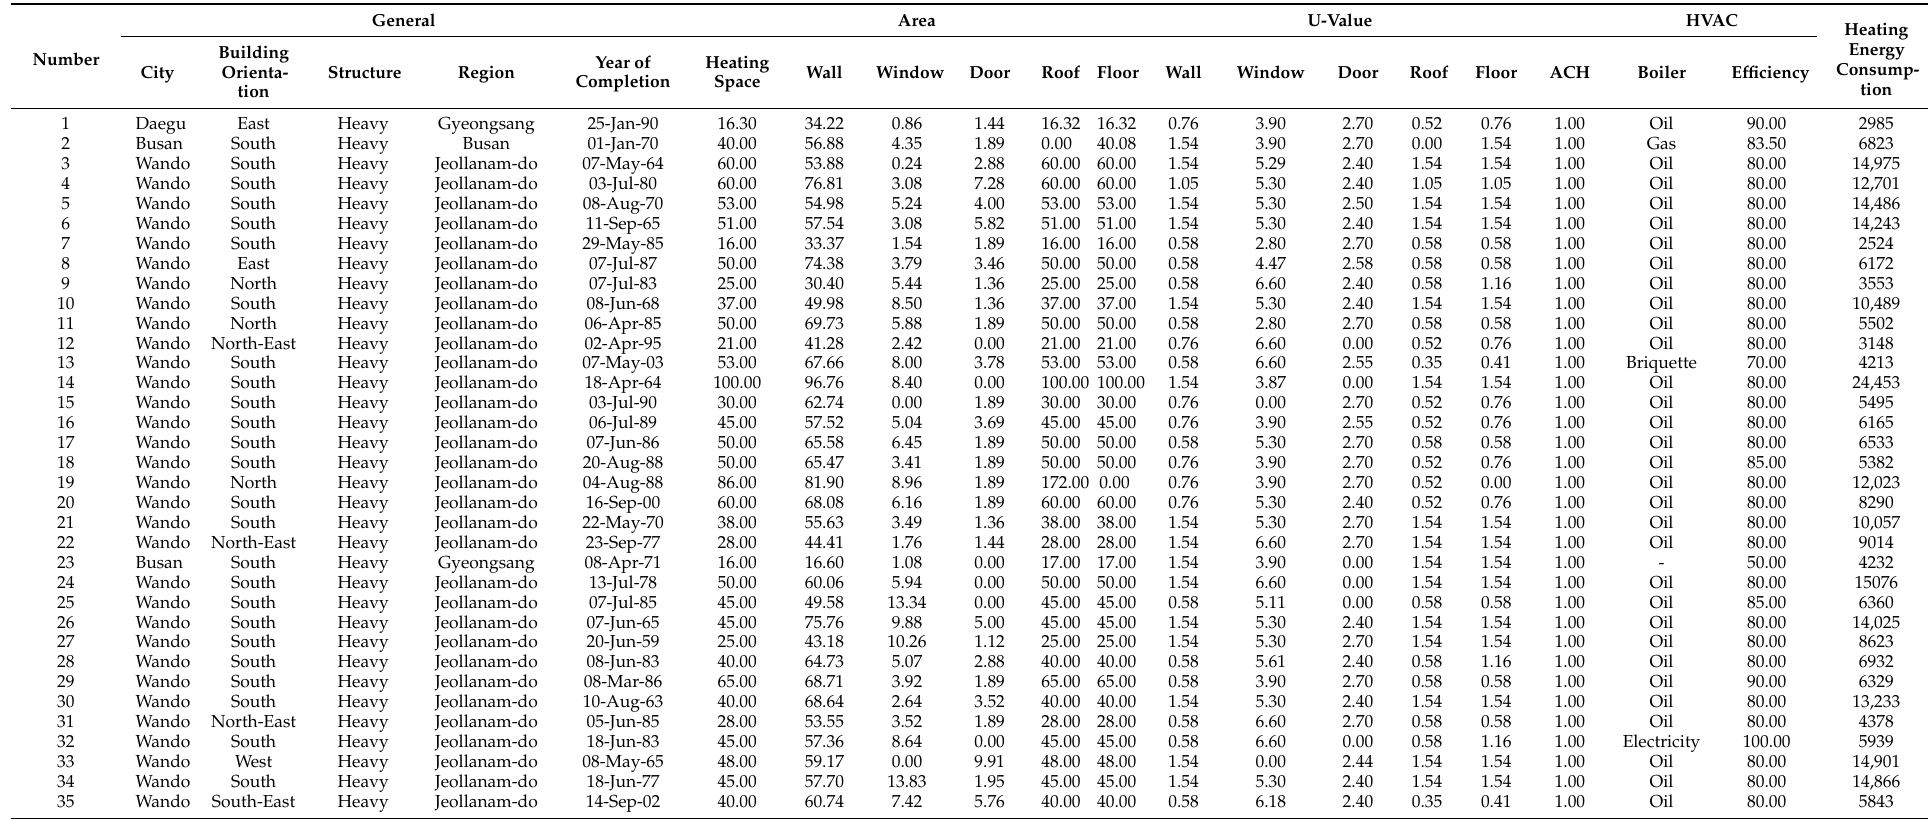
Table 1. An example of datasets that have collected building information and heating energy consumption of old